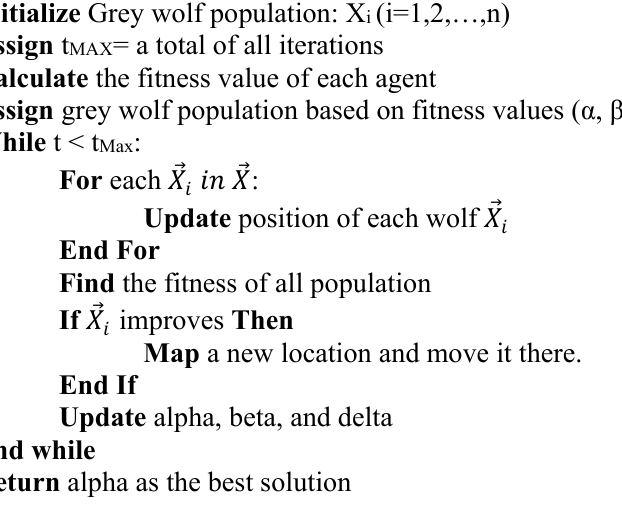
Figure 2. The Pseudocode of the optimization method. Figure 3 depicts the flowchart of the intelligent gray wolf optimizer. The best, second ‐ best, and third ‐ best solutions are represented by α , β , and Δ wolves, respectively. Each wolf’s position is determined by the approximate location of the prey. Finally, α is re ‐ turned as the best response. A schematic representation of the experimental approach in combination with an optimization technique is illustrated in Figure 4.